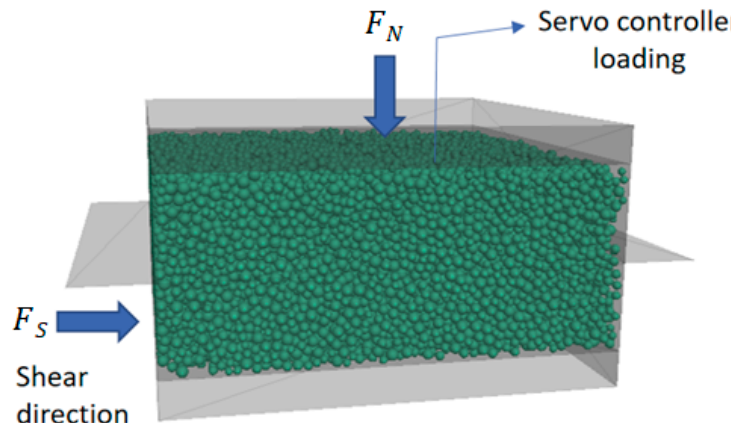
Figure 3. The developed DEM model of the direct shear